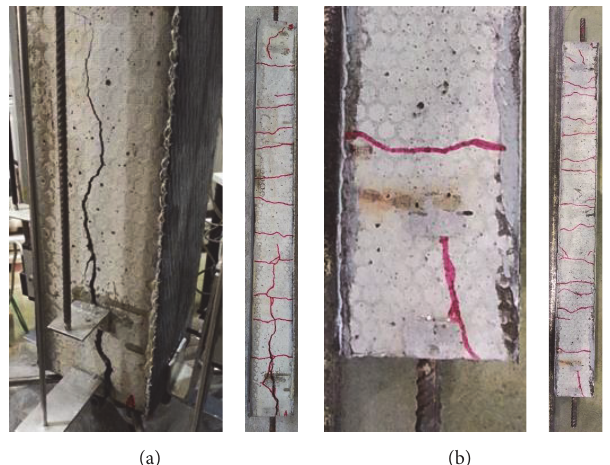
Figure 6: Failure character of RC tensile specimens: splitting of the ordinary concrete prism in the tie T1-C3-F0 (a); absence of failure of the tie T2-C1-F0.6 made of SFRC